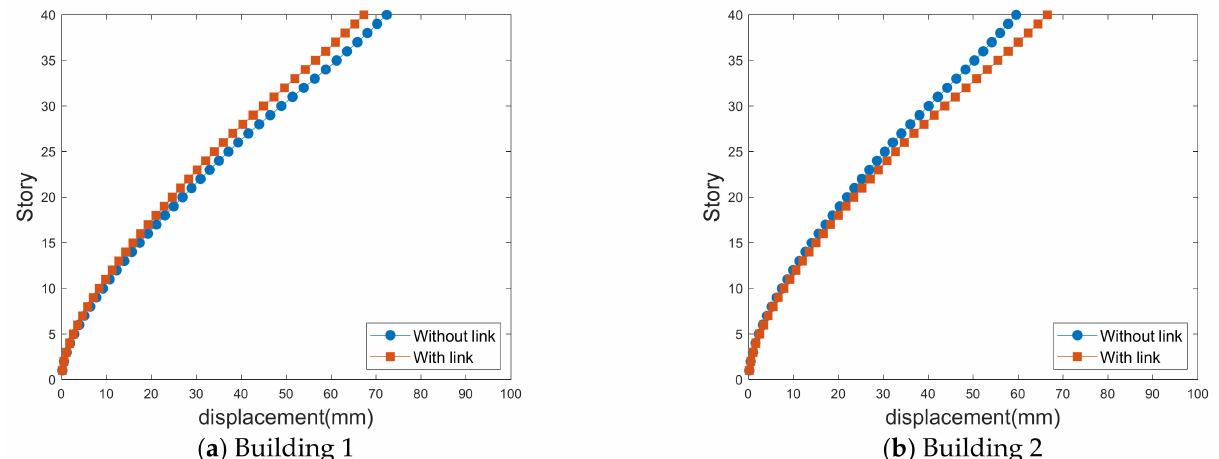
Figure 13. Along-wind-induced lateral displacements with a small gap